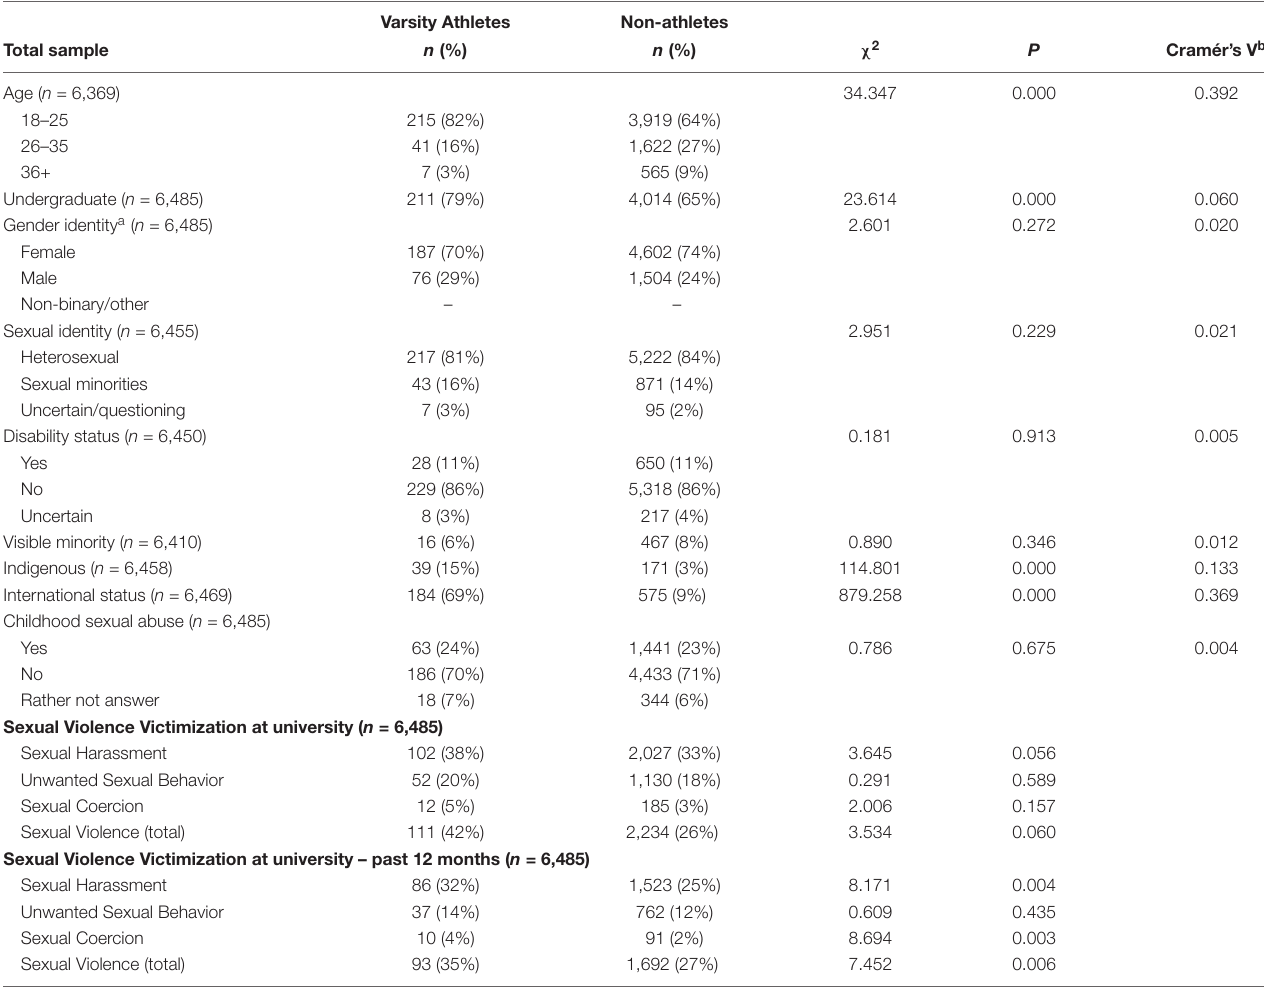
TABLE 1 | Sociodemographic comparisons between varsity athletes and non-athletes. Varsity